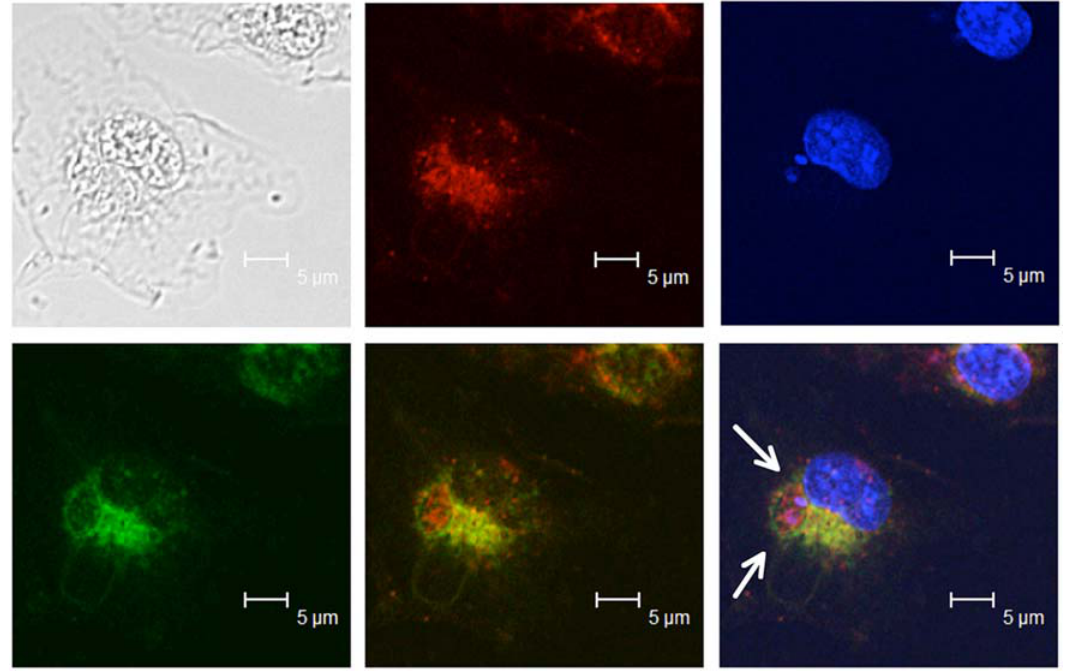
Figure 2. TLF accumulates within the PV in L.major infected macrophages. BALB/c bone-marrow derived macrophages were infected with L. major metacyclics for 2 hours before treatment with prelabelled-Alexa 594-TLF (10 m g/ml) for 2 hours. The grey panel is a transmission light micrograph of the imaged macrophage. The red panel depicts the uptake of labeled TLF by the macrophage. The blue panel depicts the nuclei of the macrophage (large blue area) and intracellular Leishmania parasites (small blue dots) stained with DAPI. Lysosomes were stained with anti-Lamp-1 antibodies (green). The merged panel shows a Lamp-1 delineated PV full of TLF (arrows). Samples were visualized with a Leica TCS SP2 AOBS confocal laser scanning microscope.